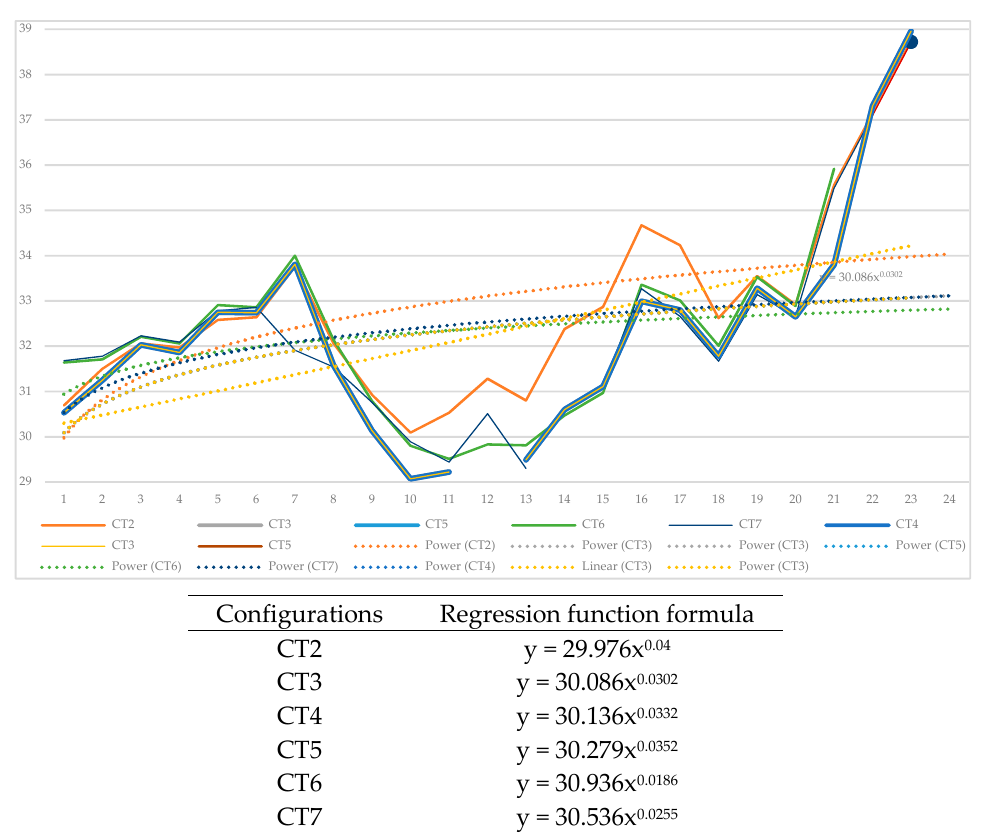
Figure 7. Maximum ambient air temperature in compact - type arrangement on 17th January with their associated regression function formula.